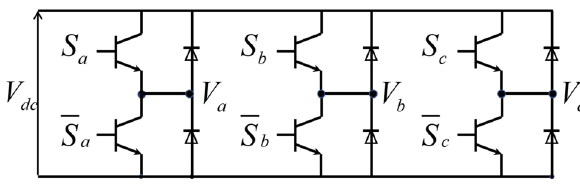
Figure 3. The hardware topology of three-phase two-stage